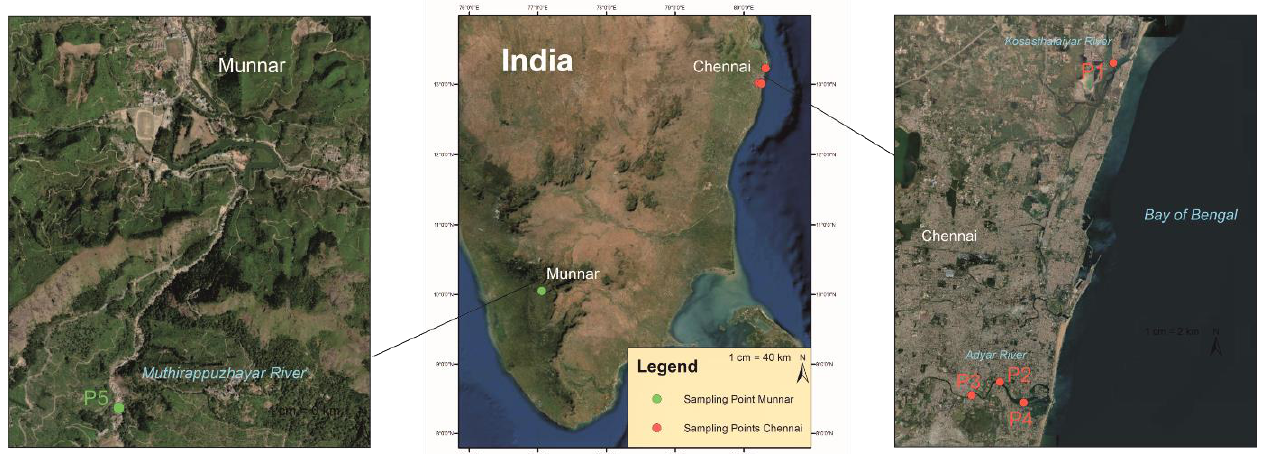
Figure 1. Overview map of all sampling sites in Chennai (urban area: high anthropogenic influence) and Munnar (rural area: low anthropogenic influence) (data basis: Arc GIS Basemap).